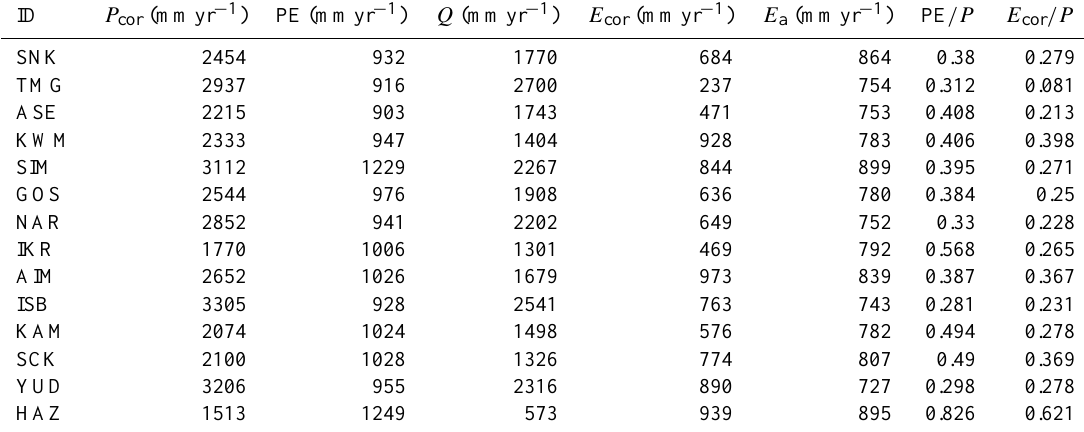
Table 2. Estimated climate variables and indices.